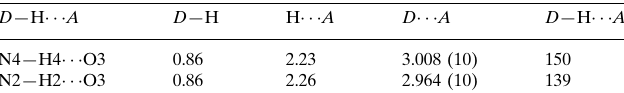
Rigaku Saturn724 diffractometer Absorption correction: numerical ( CrystalClear ; Rigaku/MSC, 2006) T min = 0.279, T max = 0.547